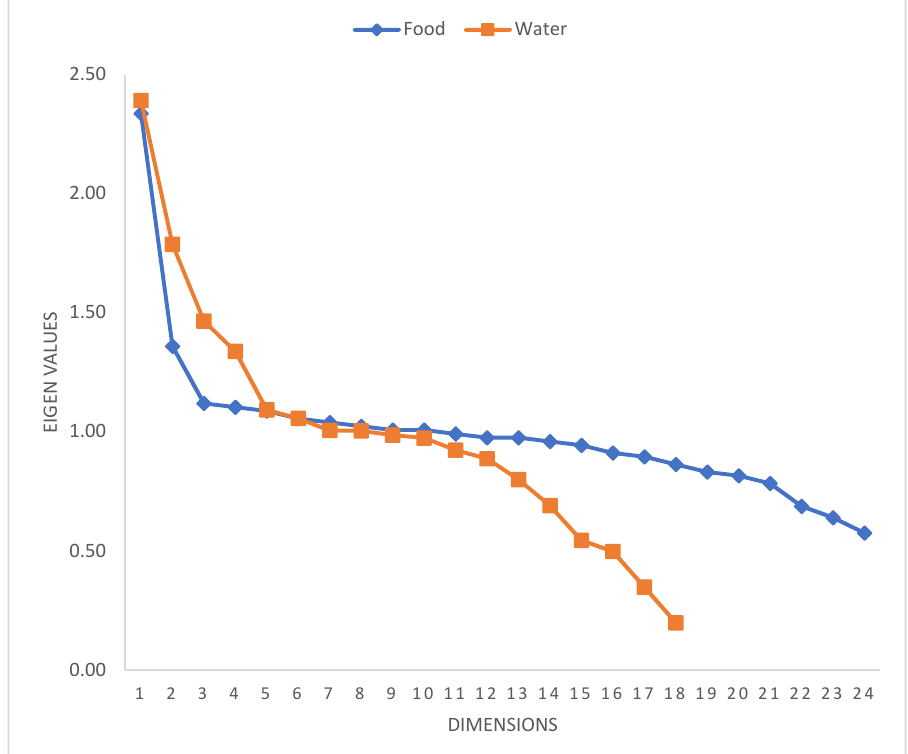
Figure 2. Scree plots of food and water dimensions. We therefore chose three dimensions for FI. They are named as follows based on the items that loaded on them (table 4): (1) “ poor food access ” (food not preferred, insufficient food, food help and food on credit), (2) “ household shocks ” (economic shocks, agriculture shocks and health shocks), and (3) “ low food availability and quality ” (stock of staple food, garden and household diet diversity). These dimensions accounted for a cumulative variance of 20.12%. Similarly, the WI dimensions are named according to the characteris- tics they capture (Table 4): (1) “ poor water access ” (time to drinking source, distance to drinking source, time to non-drinking source, distance to non-drinking source), (2) “ poor water quality ” (drinking source, non-drinking source, water satisfaction), and (3) “ low water reliability ” (whether drinking and non-drinking sources ran dry). Together, these dimensions accounted for a cumulative variance of 31.36%. Table 4. Squared correlation ratios, eigenvalues, percentage variances and descriptive statistics of multiple correspond- ence analysis for final dimensions in each food insecurity and water insecurity measures. Food Insecurity ( N = 3551)